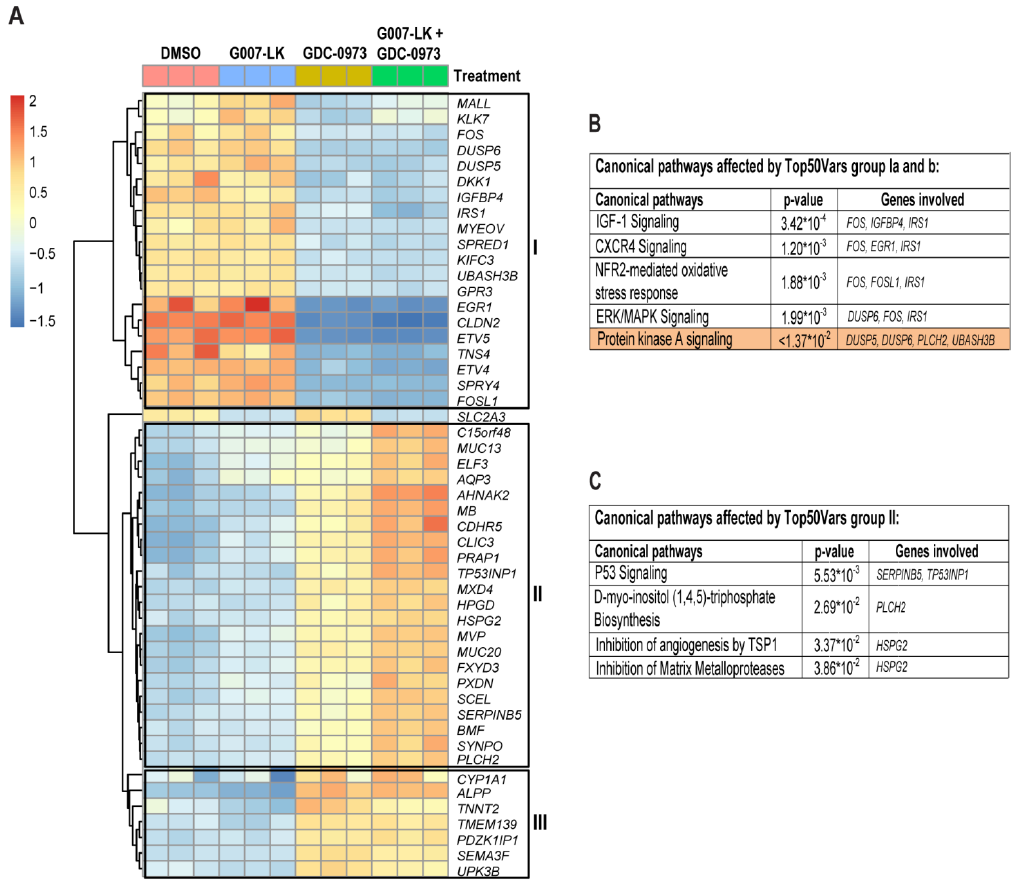
Figure 4. Characterization of the 50 most regulated genes regardless of inhibitor treatment in HCT-15 cells A heatmap of the 50 most regulated genes across the different treatments compared to the DMSO control was created ( A ). 3 distinct groups of regulations were revealed. One group (I) consisting of 20 genes was mainly downregulated by the MEKi, with minor additional changes in combination with TNKS inhibition. A second group (II) consisting of 22 genes was moderately upregulated by the TNKSi, more clearly upregulated by the MEKi, and additively upregulated by combined TNKSi/MEKi treatment. The third group (group III) consisting of 7 genes was upregulated by the MEK inhibitor, with minor additional changes in combination with TNKS inhibition. SLC2A3 (GLUT3) gene transcription was downregulated by the TNKSi, with minor additional changes in combination with the MEKi. Canonical pathways predicted by the Ingenuity pathway analysis (IPA) core analysis to be regulated by group I and III is indicated in ( B ). With an applied cutoff at ( z -score > ± 2, padj < 0.01), only the Protein Kinase A pathway was significantly affected (highlighted). The canonical pathways predicted by the IPA to be regulated by genes in group II is shown in ( C ). Heatmap Scale bar (red = high, yellow = medium and blue = low) indicates relative differences in log2 fold change within each row. Individual regulations in biological replicates are shown for all treatment